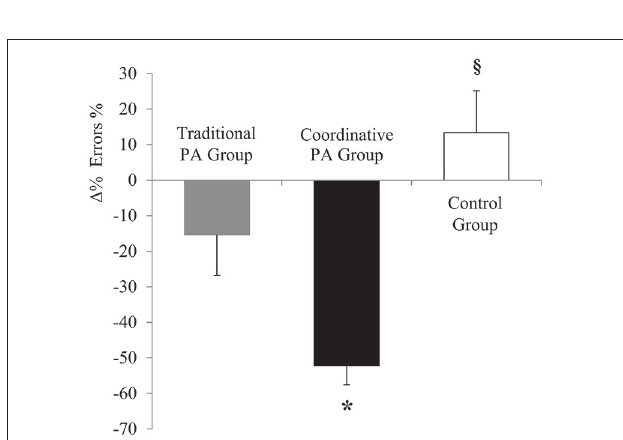
FIGURE 2 | Percentage of variation ( ∆ %) of the percentage of errors (% errors) ( ± SEM). ∗ P < 0.05 Coordinative PA Group vs. Traditional PA Group; § P < 0.05 Control Group vs. Coordinative PA Group vs. Traditional PA Group.